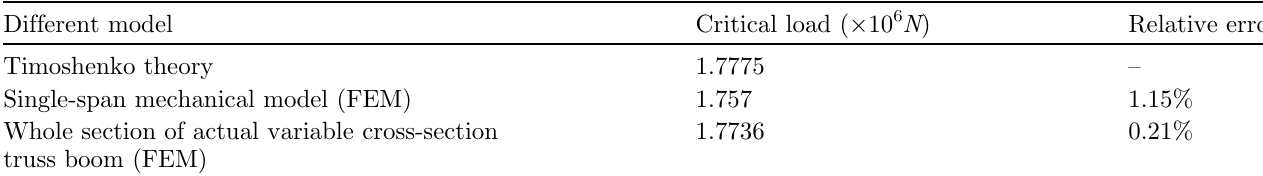
Table 3. Comparison of analysis results of three calculation models.